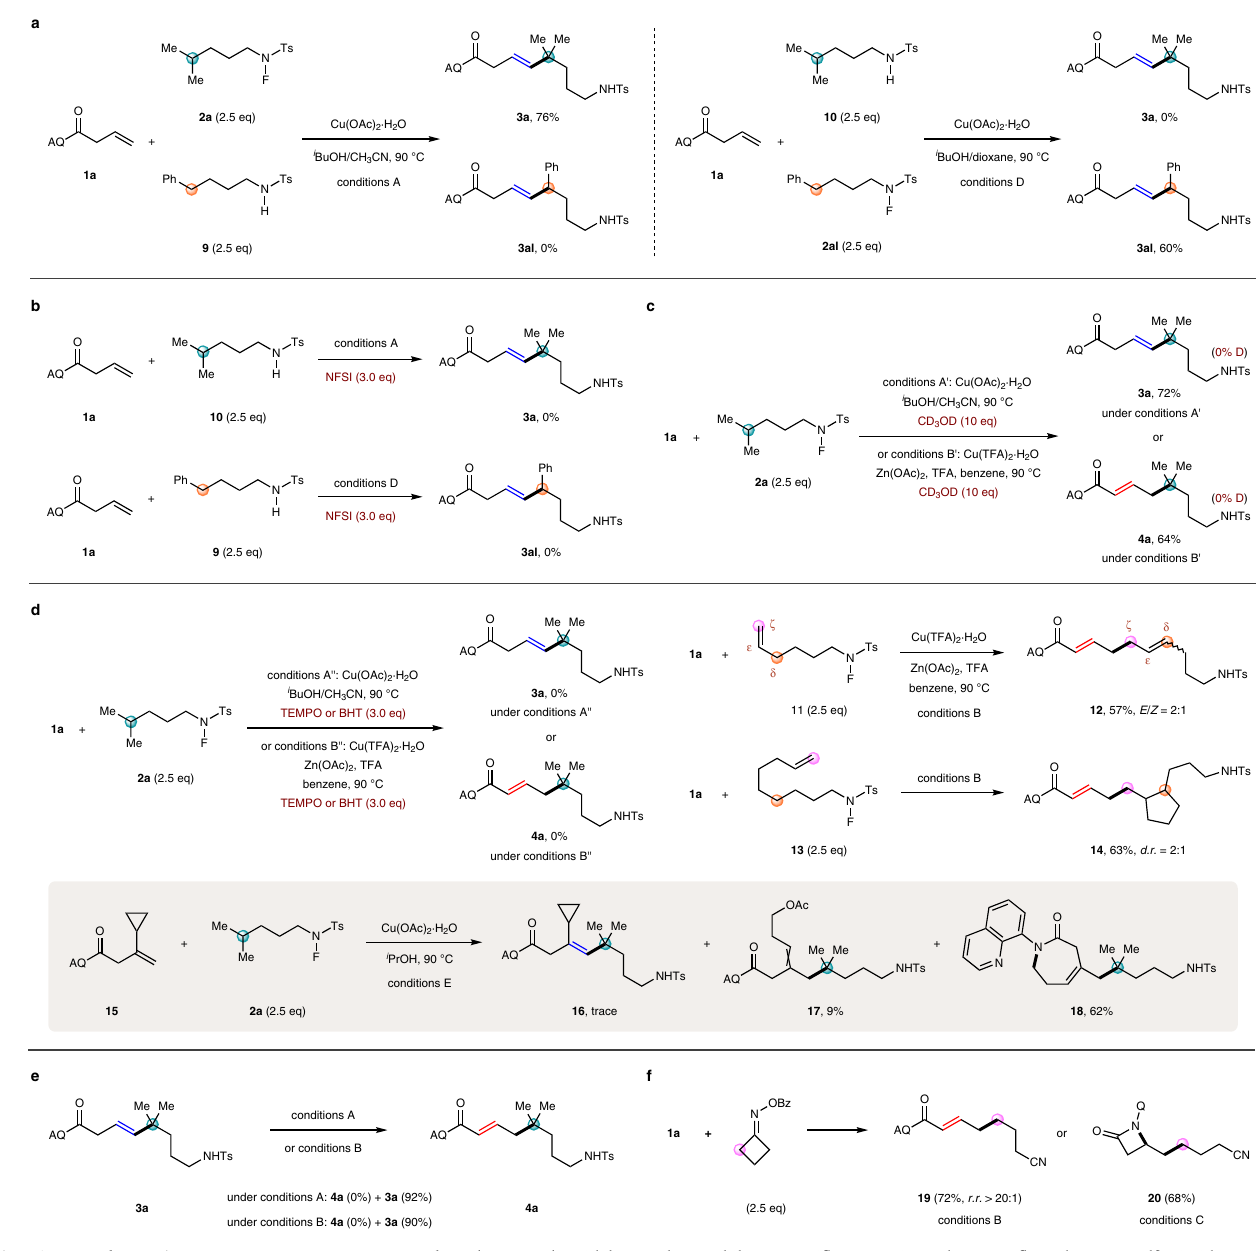
Fig. 7 | Control experiments. a Crossover experiments. b With external amidyl radicalprecursor. c Deuterium-labelingexperiments. d Radicaltrappingandradical clock experiments. e Evidence for no isomerization. f Extending to other